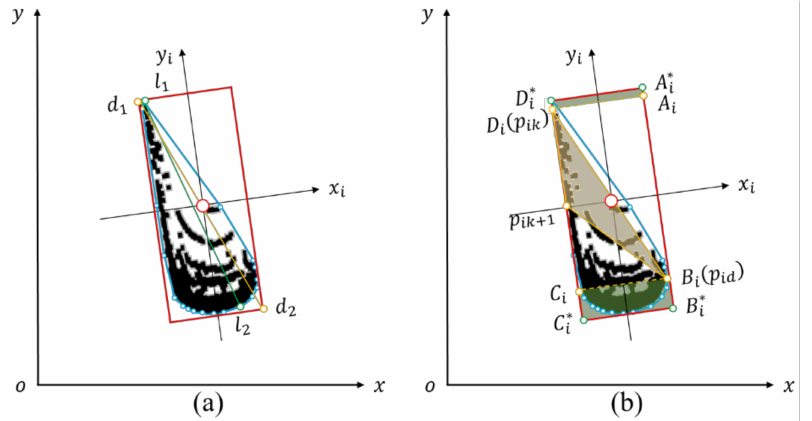
Figure 12. Illustration of the RT algorithm: ( a ) illustration of the situation faced by the RT algorithm. The longest line (green line) is not the diagonal direction (yellow line); ( b ) illustration of the RT algorithm. The yellow triangle represents the triangle with the largest area found by the RT algorithm, and the green part represents the corrected area. The mark "*" represents the corrected bounding box’s corner